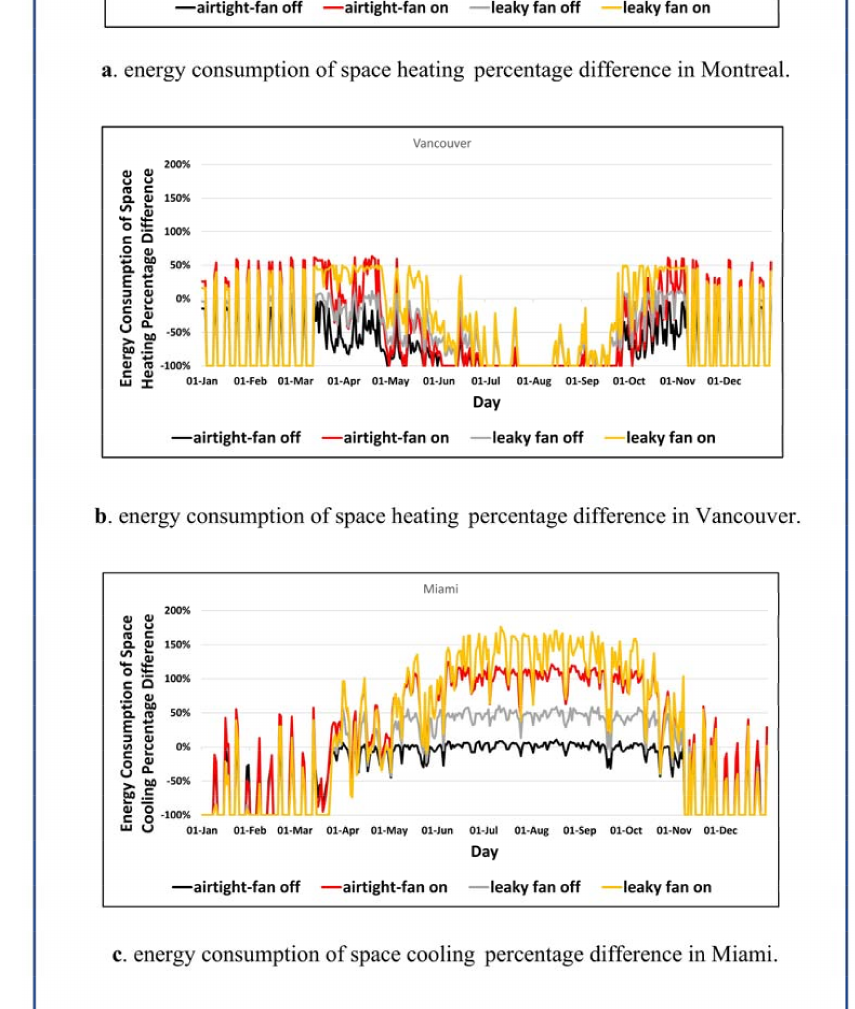
Figure 4. Comparison of the simulated EnergyPlus results of hourly space heating/cooling energy consumptions with acceptable level of ASHRAE Standard 90.1 for ( a ) Montreal, ( b ) Vancouver, and ( c )